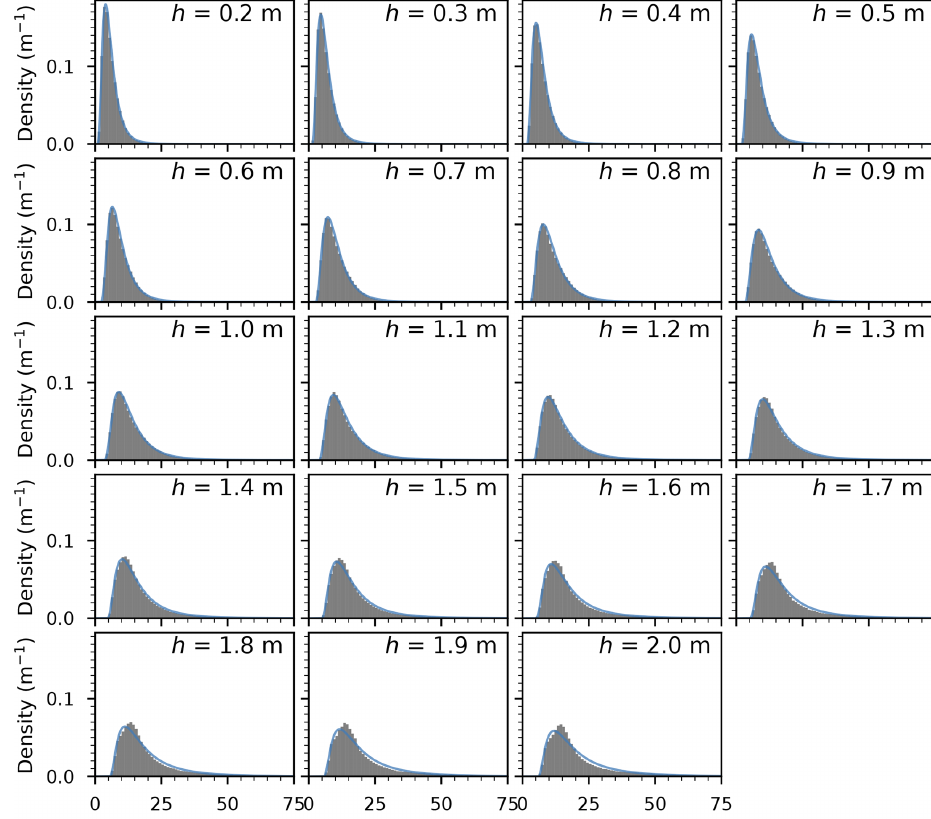
The Cryosphere, 16, 4447–4472, 2022